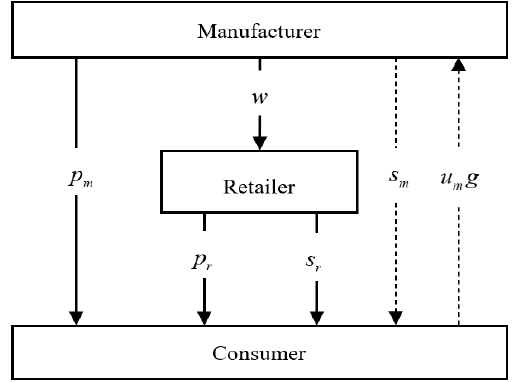
Figure 1. Manufacturer dual-channel supply chain with service and returns.